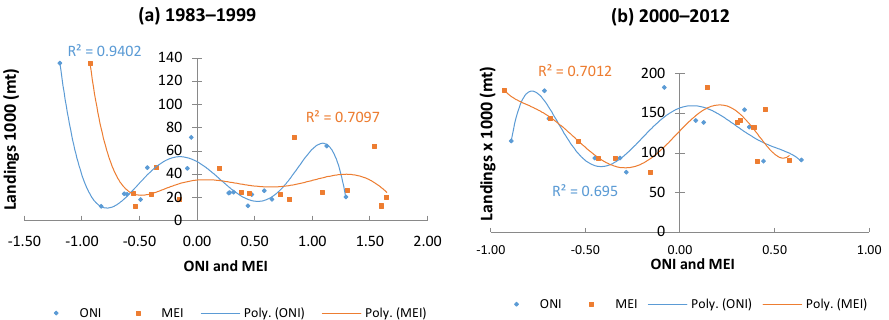
Figure 5. Skipjack landings in Ecuador, Peru and Colombia vs. ONI and MEI. Polynomial functions, n = 6. Series 1983–1999 (a) and 2000–2012 (b) . Data NOAA, IATTC (2014).